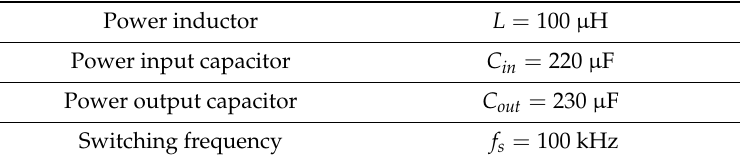
Table A1. Boost converter parameters.